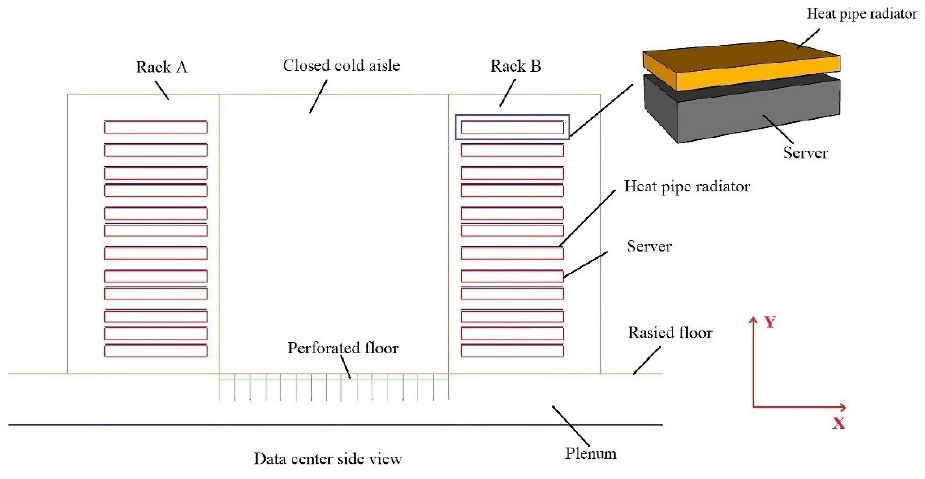
Figure 7. The cross-sectional diagram of the numerical model of the composite cooling